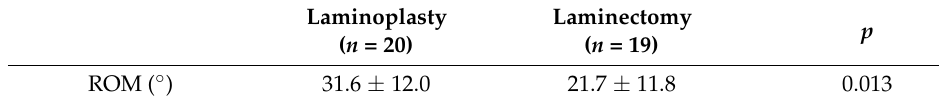
Table 3. Comparison of spinal ROM between the two groups.